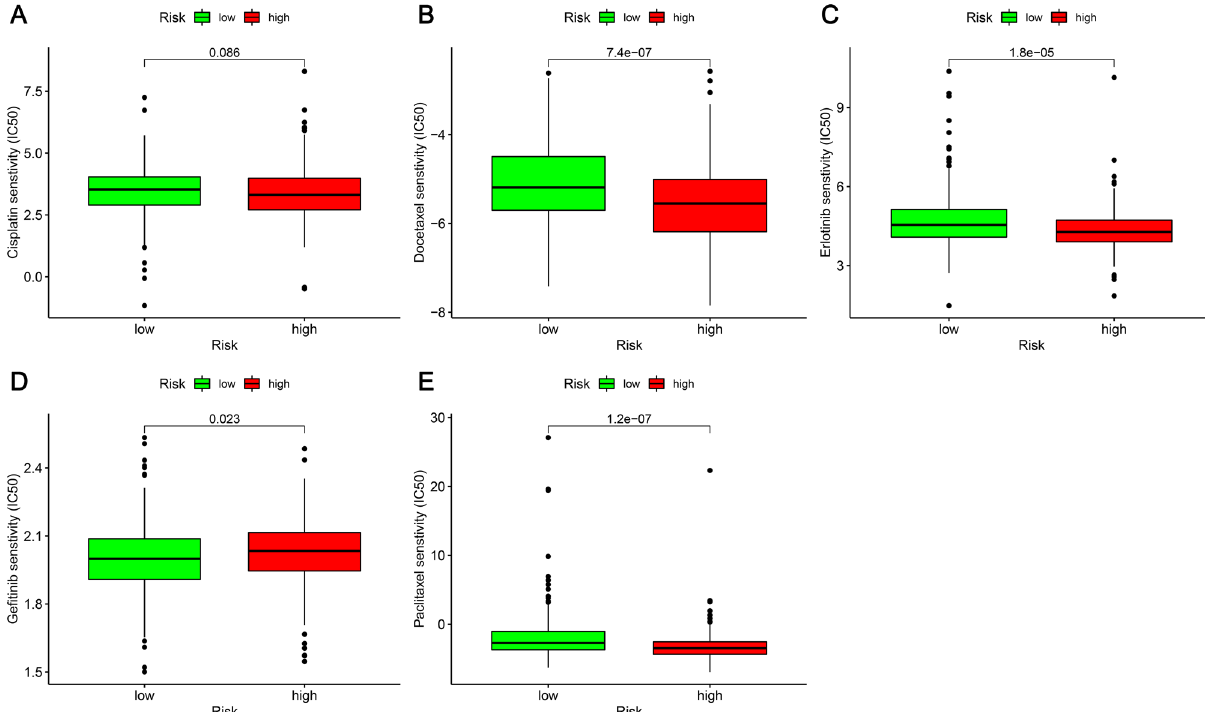
Figure 9. Correlation between risk model and chemotherapeutic drugs in LUAD. ( A ) cisplatin; ( B ) docetaxel; ( C ) erlotinib; ( D ) gefitinib, and ( E )